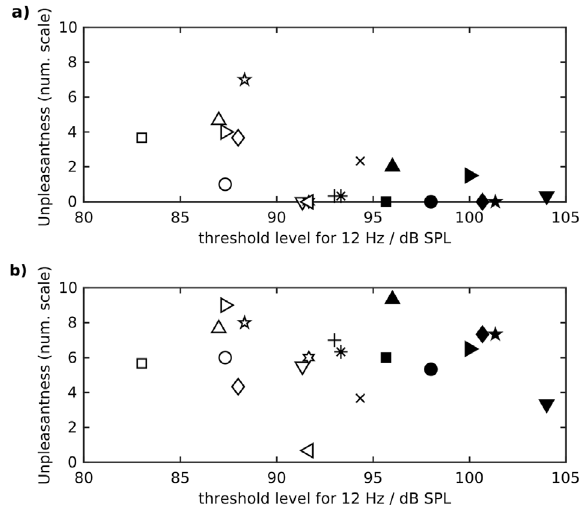
Figure 4. Unpleasantness ratings for the sinusoid at 12 Hz in isolation presented at 95 dB SPL (upper plot (a)) and at 110 dB SPL (lower plot (b)) in dependence on individual detection threshold levels for the sinusoid at 12 Hz of 19 listeners. Each marker indicates the average unpleasantness rating and average detection threshold of one